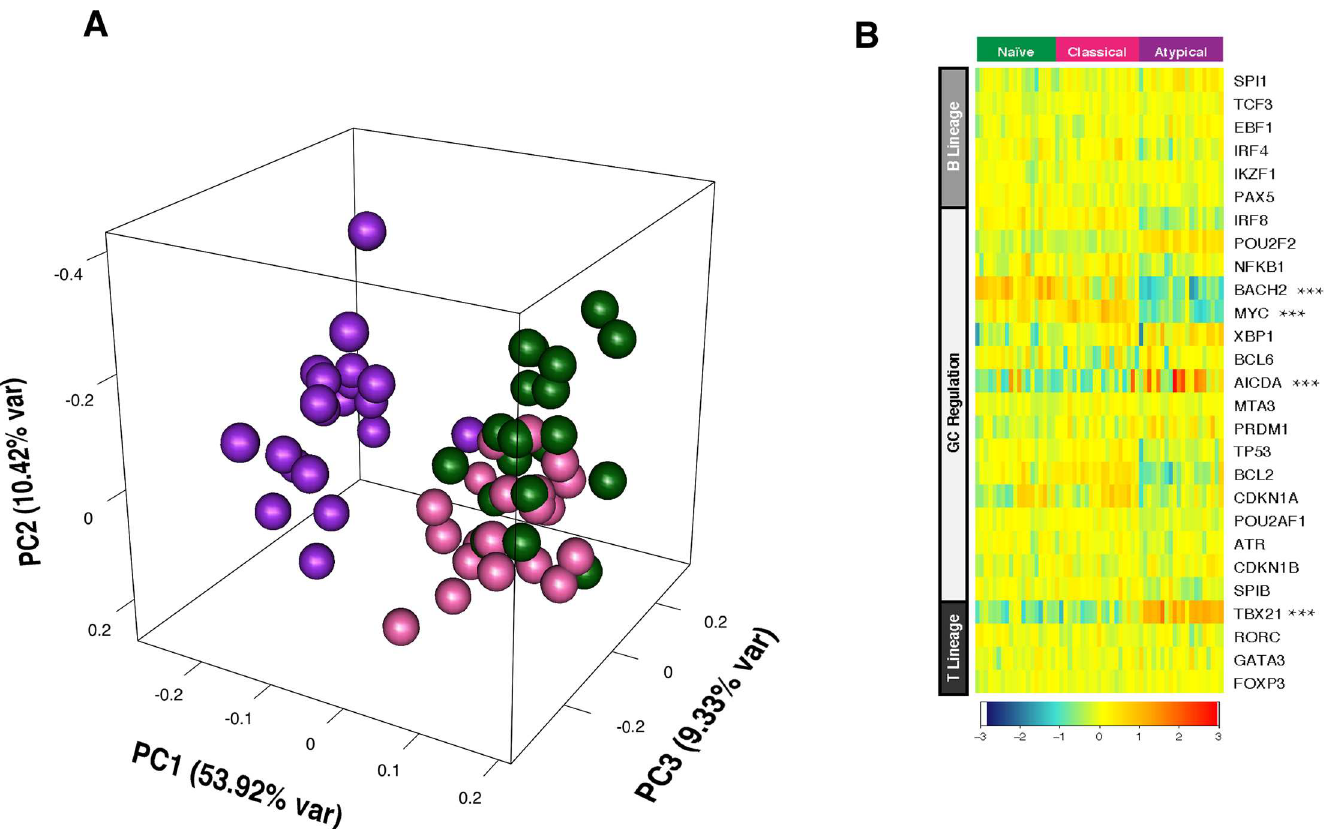
Fig 1. Malaria-associated atypical MBCs upregulate TBX21 . ( A ) Principalcomponentsanalysisof gene expressionof selectedregulatorsof B and T cell differentiation (selectedgenes shown in B ) in na ï veB cells (CD19 + CD21 + CD27 − ; green), classical MBCs (CD19 + CD21 + CD27 + ; pink) and atypical MBCs (CD19 + CD21 − CD27 − ; purple). ( B ) Ex vivo RMA-normalizedlog2 gene expressionvalues of selectedregulatorsof B and T cell differentiation(rows) for each subject (columns; n = 20) within each B cell subpopulation.Differentially expressed genes in atypical MBCs relativeto classical MBCs are indicatedwith an